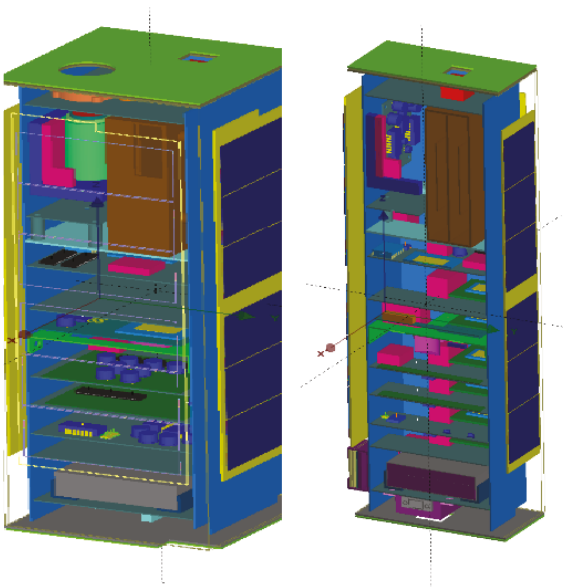
Figure 1: OPTOS 3D radiation model as built with FASTRAD tool.